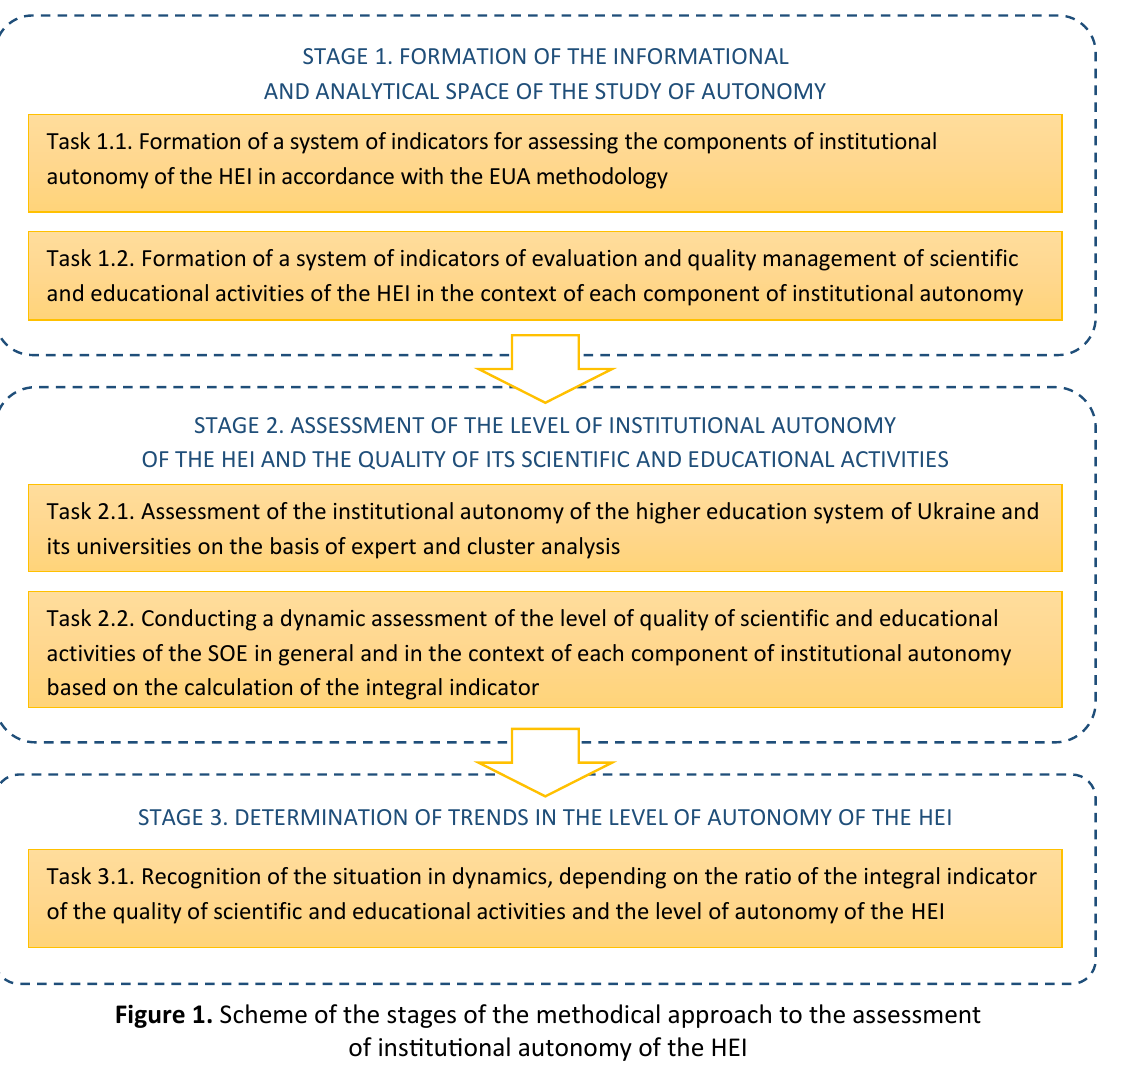
Figure 1. Scheme of the stages of the methodical approach to the assessment of institutional autonomy of the